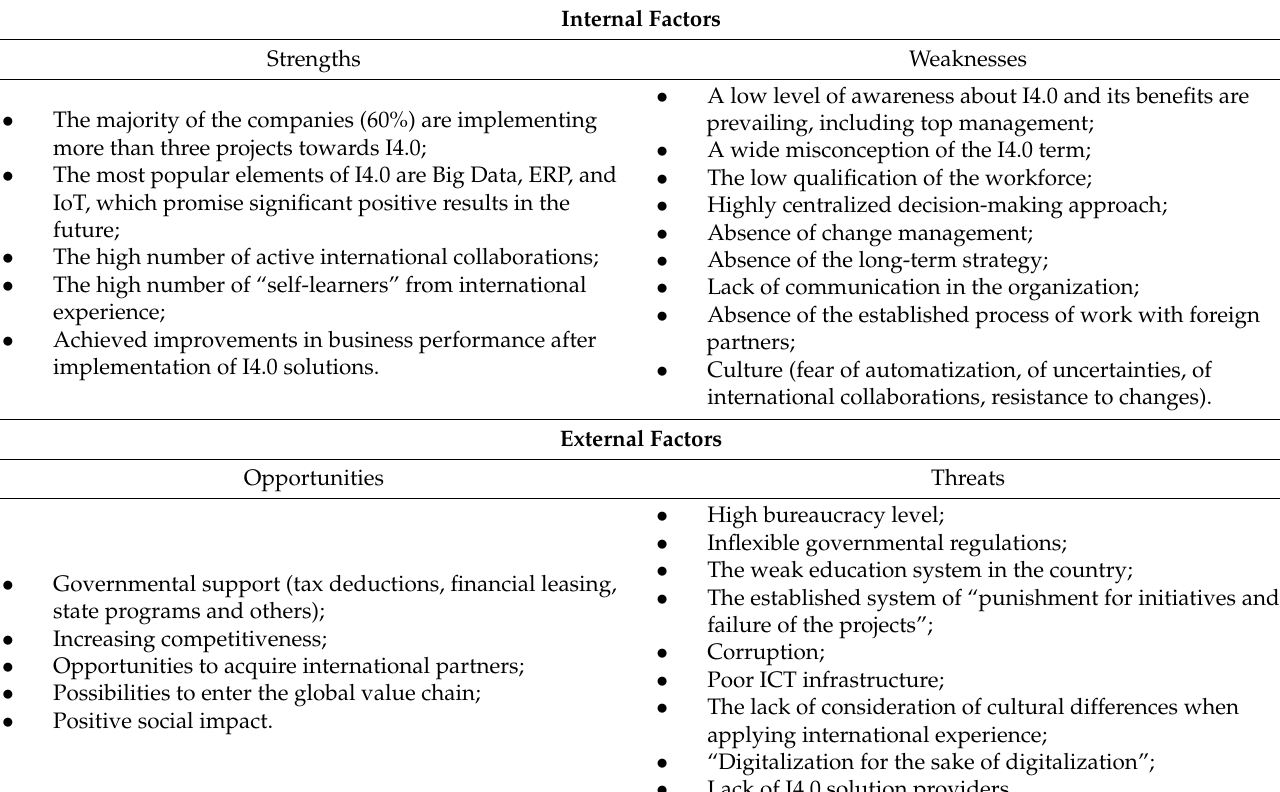
Table 5. SWOT analysis of enterprises in Kazakhstan in the I4.0